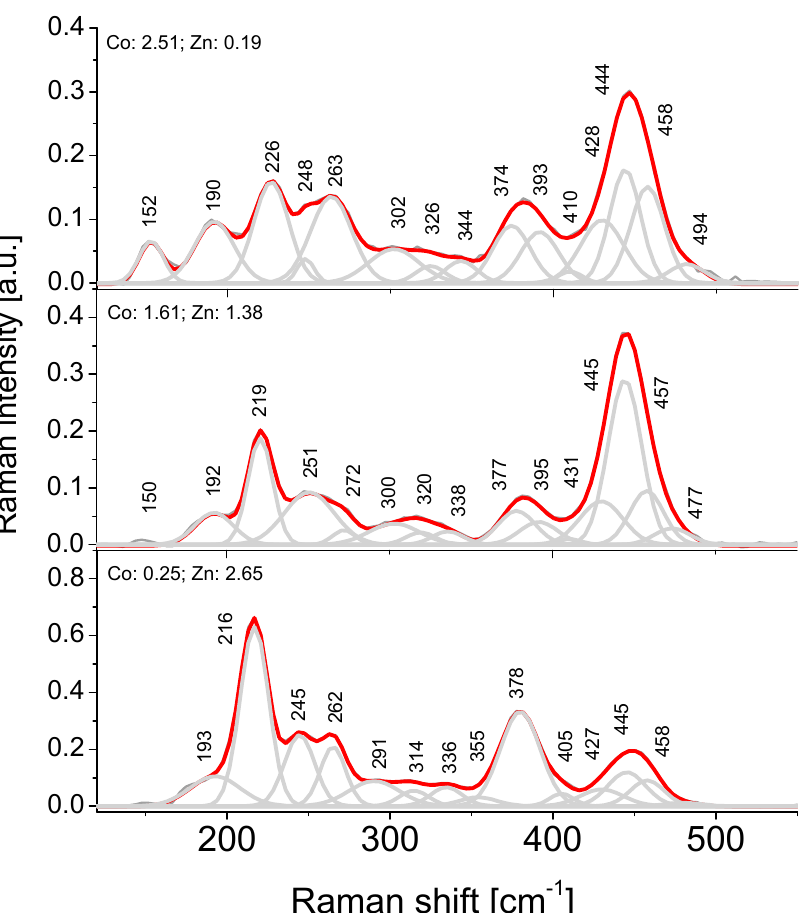
Figure 10. Fitted Raman spectra of members of the erythrite–köttigite solid solution within the range 100–500 cm –1.